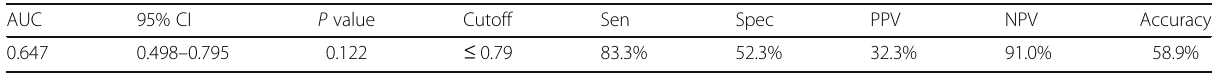
Table 2 explore the discriminant ability of mean ADC value to differentiate (grade III) from (grades I and II) tumors AUC 95% CI P value Cutoff